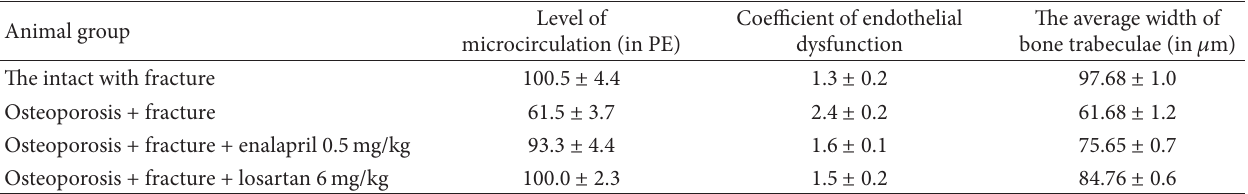
T1:IndexofMicrocirculation,coefficientofendothelialdysfunctionandtheaveragewidthofbonetrabecularintheproximalmetaphysis of the femur, the once received treatment with the studied medication is compared with control group.